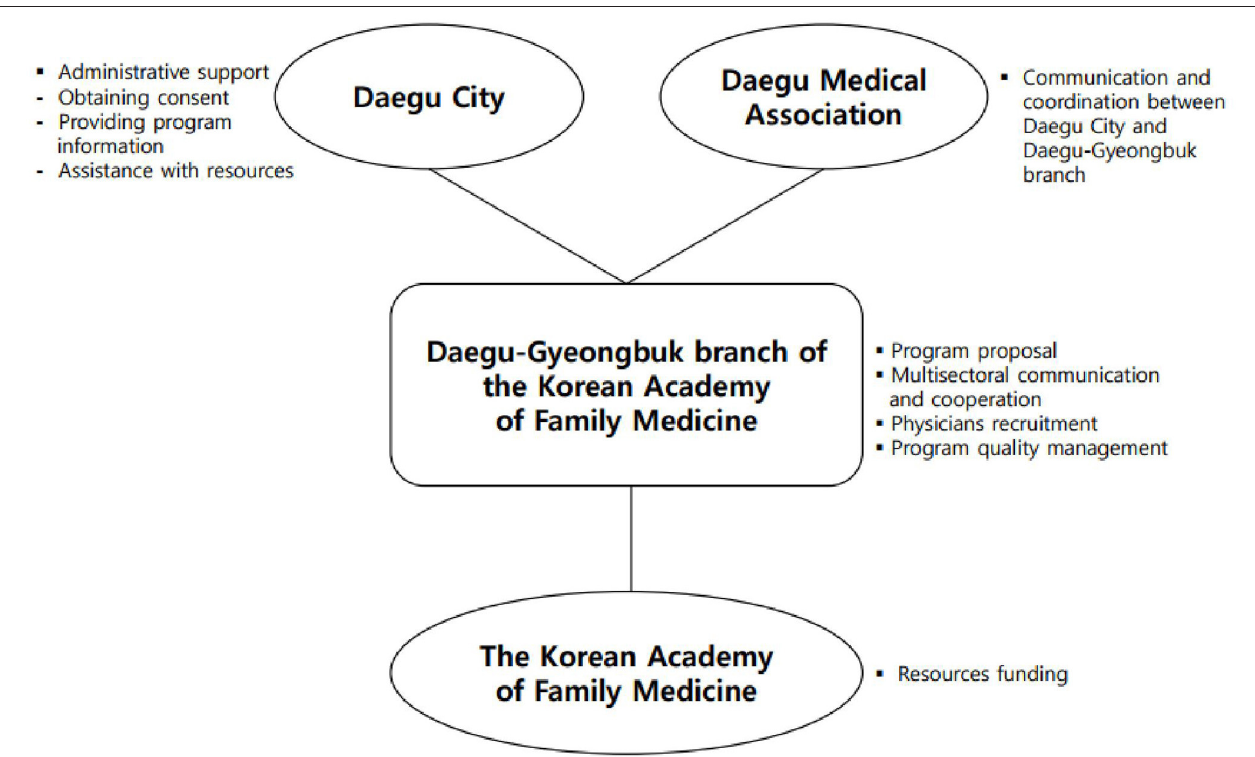
FIGURE 1 | Physician-based intervention model in cooperation with the government and medical